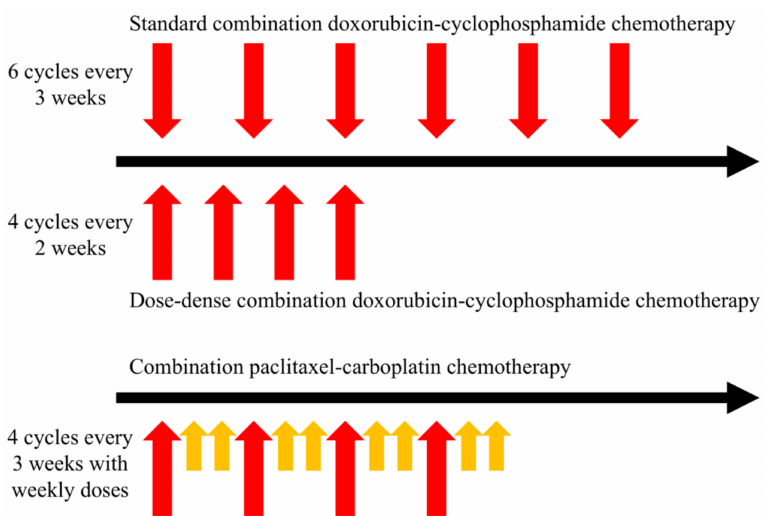
Figure 1. Comparison of three neoadjuvant regimens of chemotherapy for triple-negative breast cancer. Red arrows represent the first dose of every cycle, and yellow arrows represent doses during the course of a cycle. The dose-dense combination doxorubicin-cyclophosphamide therapy regimen consists of fewer cycles over a shorter period of time with the same dosage compared to the standard regimen—where both drugs are given for every dose. While patients are more likely to experience side e ff ects during the dose-dense regimen (with shorter recovery periods between cycles), the treatment is completed in half the time. For the combination paclitaxel-carboplatin regimen, carboplatin is administered at the beginning of each cycle (4 doses), and paclitaxel is given weekly (12 doses). Without a framework to evaluate these regimens against each other on a patient-specific basis, there is no way to know which regimen (or an alternative regimen) may be more beneficial for treatment. Given clinically relevant models of tumor response to therapy, optimal control theory (OCT) may be employed to systematically investigate numerous regimens in silico to identify optimal treatment approaches on an individual patient